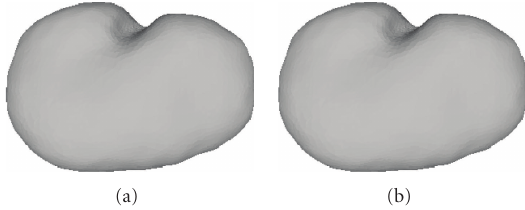
Table 2: Dimension of dictionary ( J/I ).